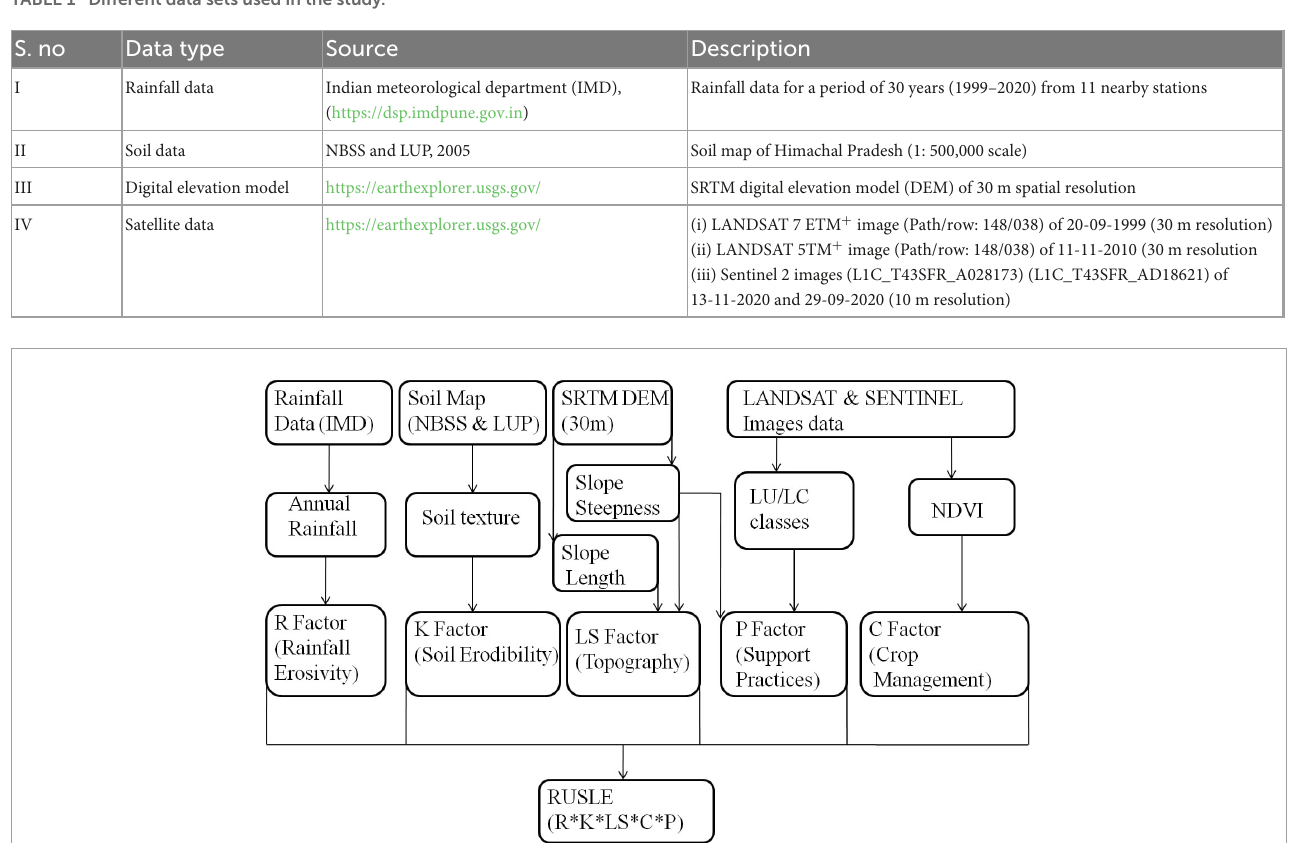
TABLE 1 Different data sets used in the study.